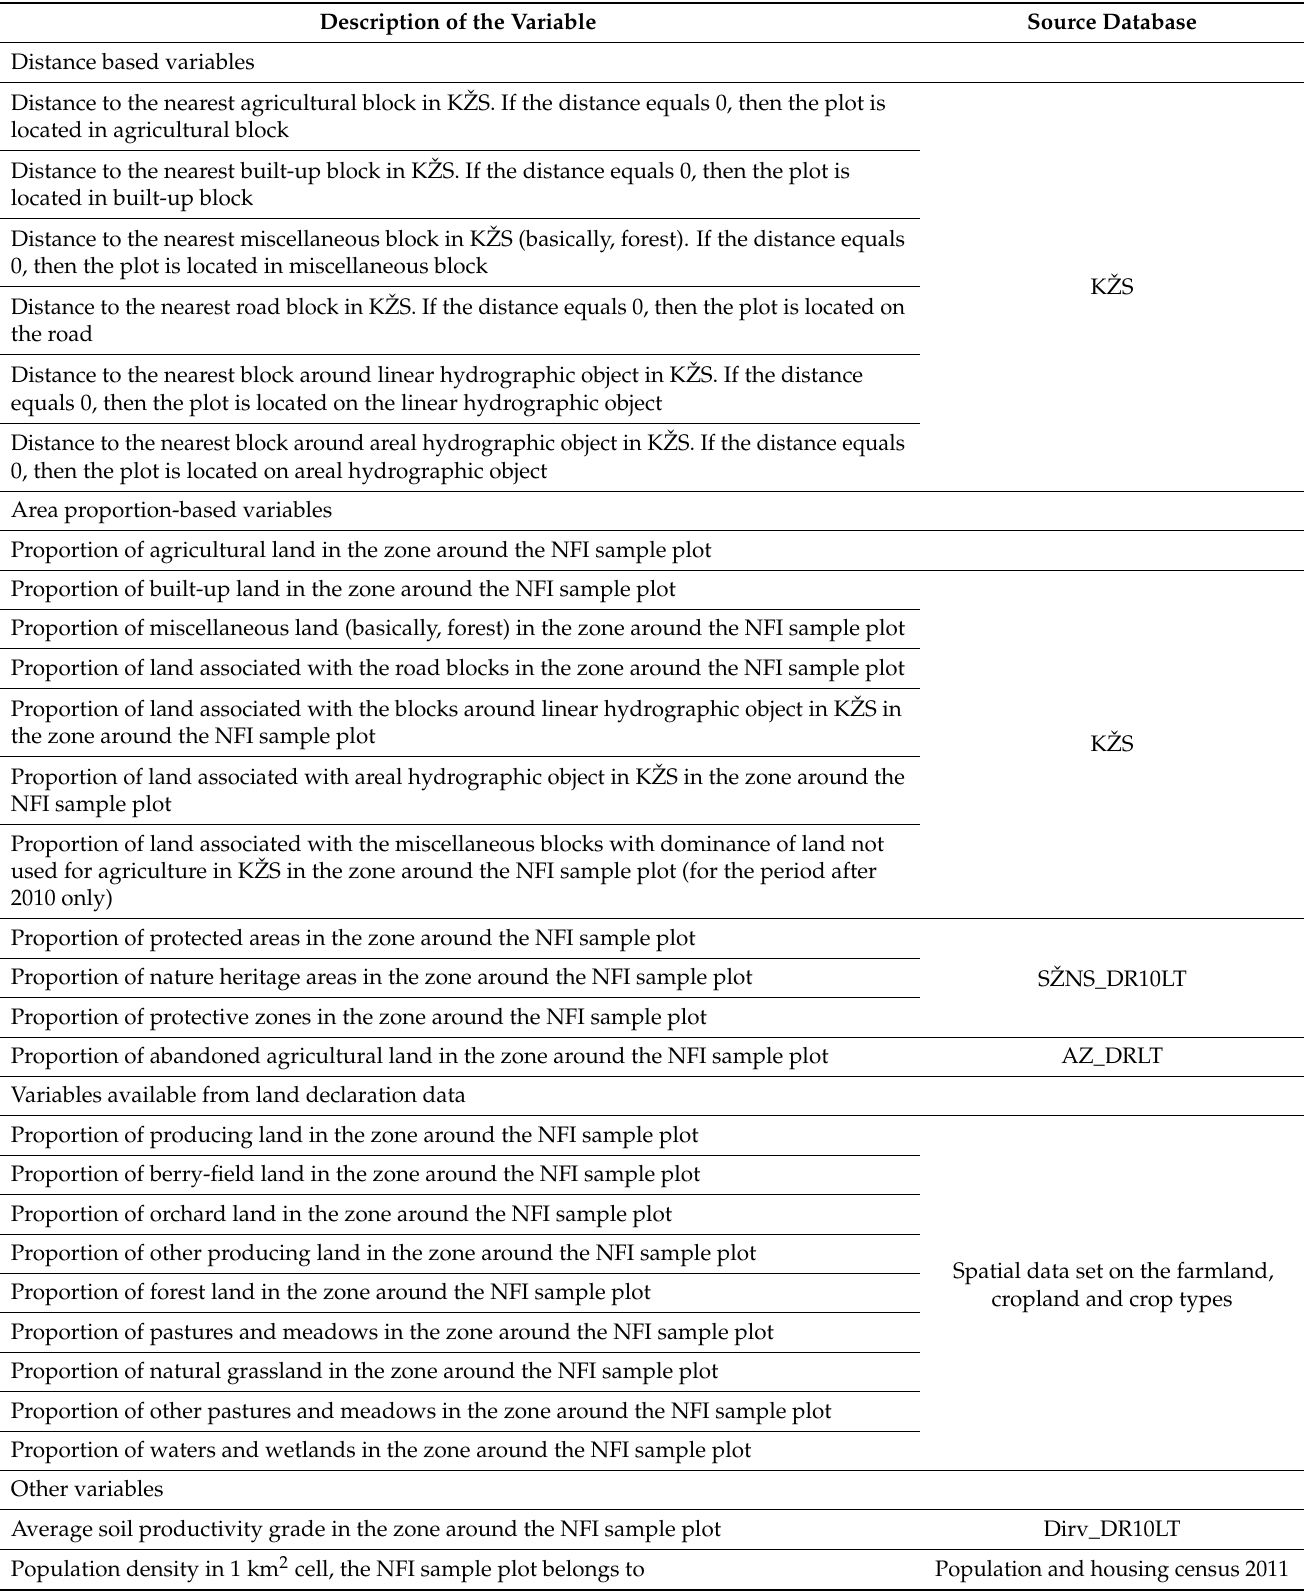
Table A2. List of explanatory variables tested to predict the land use transition